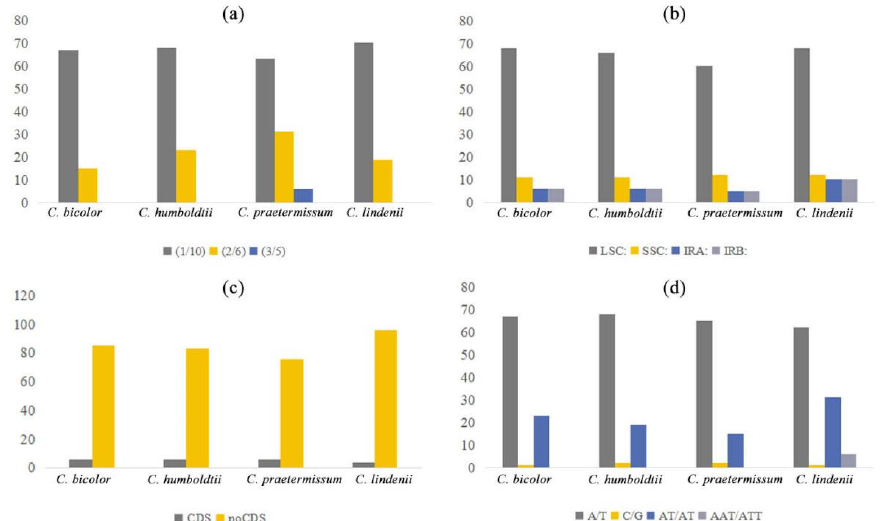
Figure 4. Comparison of repeat sequences in chloroplast genome distribution of four Caladium spe- cies. ( a ) The frequencies of different SSR repeat classes; ( b ) The SSR distribution in different chloroplast genome regions; ( c ) The SSR distribution in CDS and noCDS; ( d ) The SSR distributions of mono-, di-, and trinucleotide motifs.